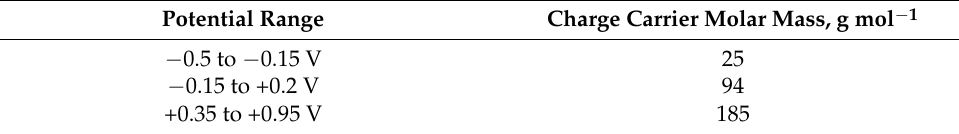
Figure 4. Mass-charge plot ( ∆ m vs. ∆ Q) for the CV/EQCM test of the poly-[Co(Amben)] film conducted at a scan rate of 25 mV s − 1 (black curve) and linear regions used to calculate the molar masses of injected mobile charge carriers (red lines). Table 1. Mass of charge-compensating species entering poly-[Co(Amben)] film during oxidation at different potential ranges.